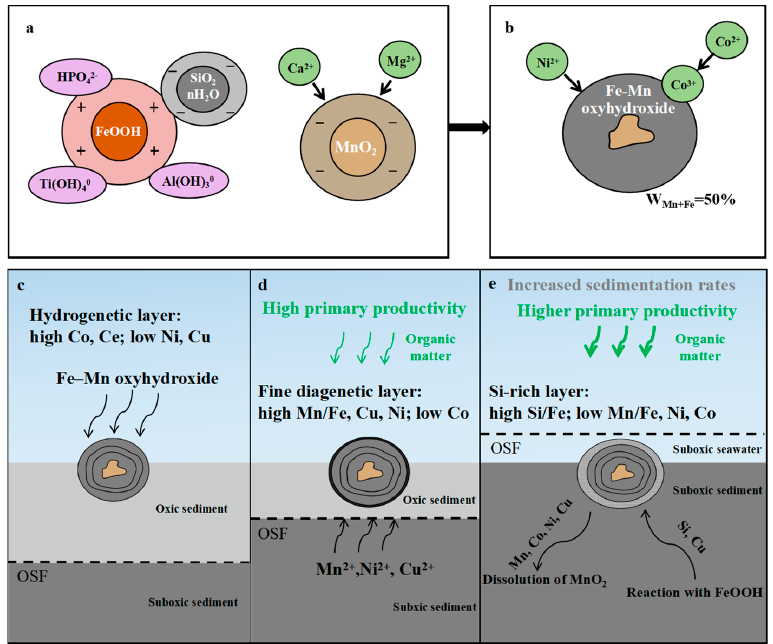
Figure 12. Model summarizing the main processes during the formation of the nodules in this